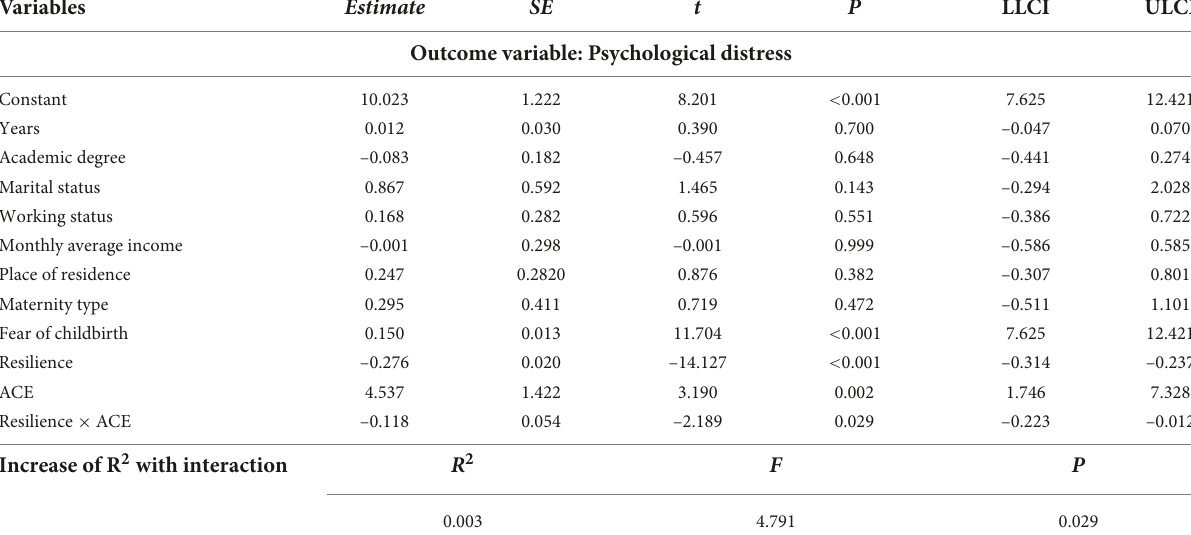
TABLE 6 The moderated effect of ACEs on the association between resilience and psychological